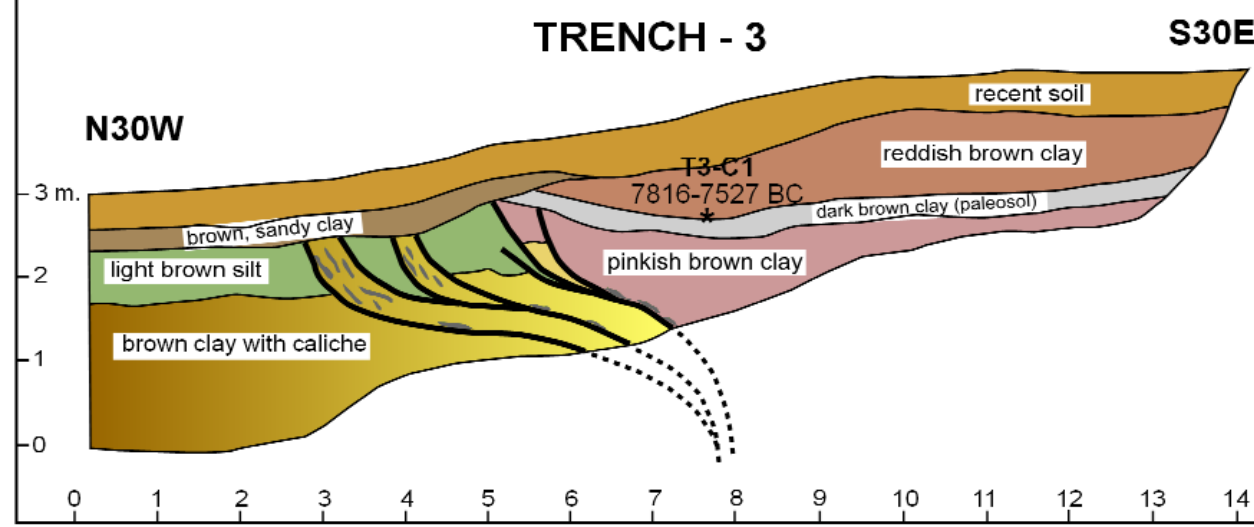
Figure 10. Log of Trench-3, eastern wall.